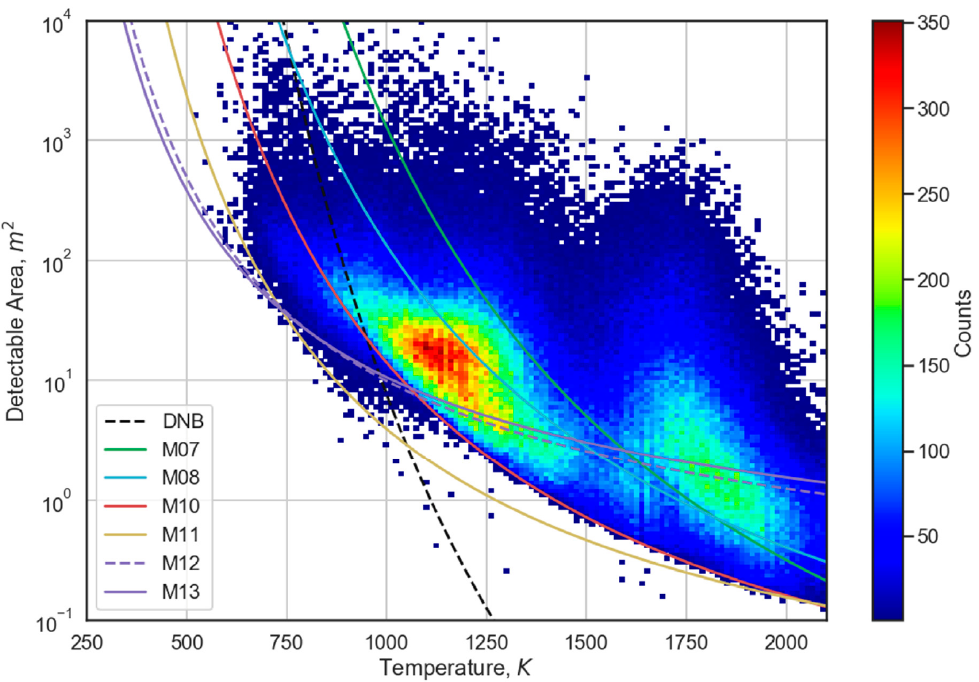
Figure 2. The nighttime combustion source detection limits of VIIRS processing workflow [9]. The natural gas flare’s temperature is generally greater than